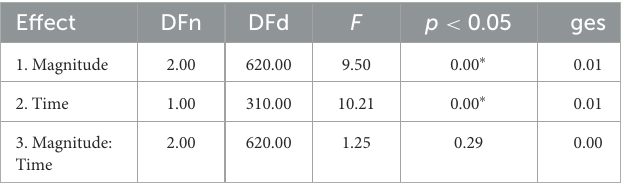
4 h or more; and the remaining 9% use them for 1 h or less per day. TABLE 2 Factorial analysis of variance for repeated